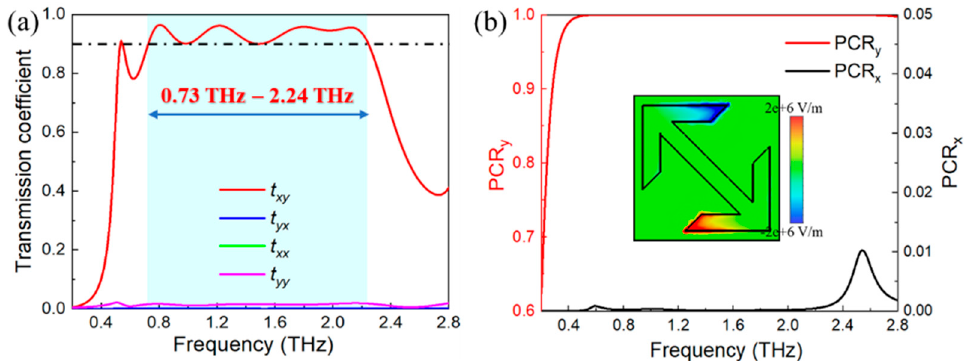
Figure 2. ( a ) The transmission coefficients of proposed metasurface. ( b ) The corresponding polarization conversion and the insertion is electric field distribution of middle layer at 1 THz.